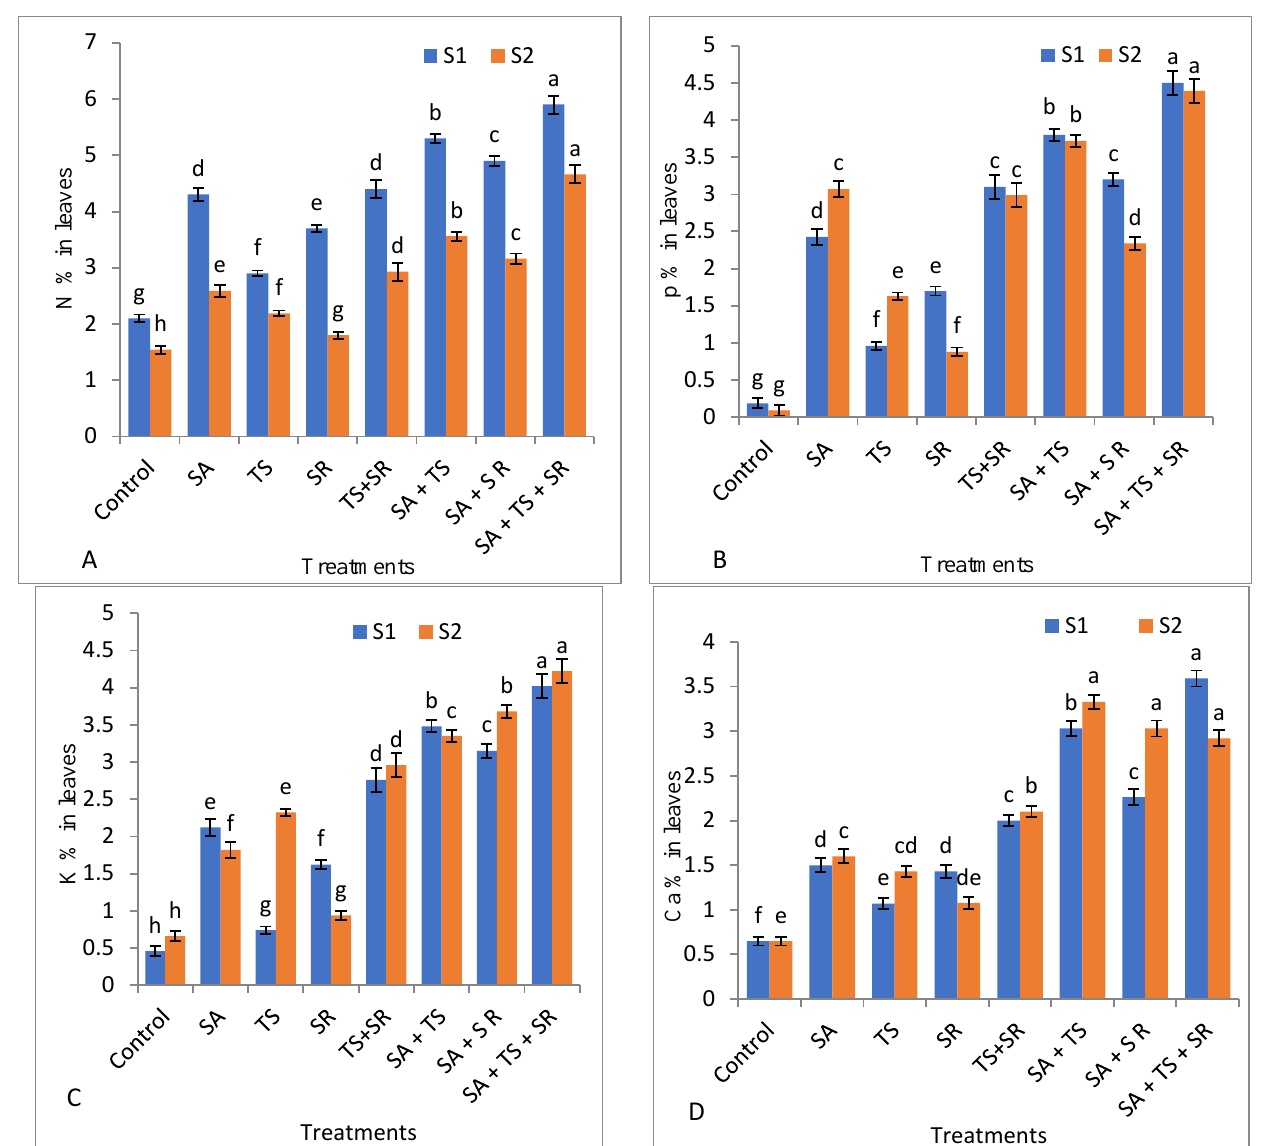
Figure 4. Effect of shikimic acid (SA) seed priming rates 40 ppm and foliar applications of water (control), T. asperellum (TS), S. rochei (SR), T. asperellum + S. rochei + (TS + SR), shikimic acid + T. asperellum (SA + TS), shikimic acid + S. rochei (SA + SR), and shikimic acid + T. asperellum + S. rochei (SA + TS + SR) on ( A ) N%, ( B ) P%, ( C ) K%, and ( D ) Ca% in leaves during two seasons. Standard errors of the mean are shown as vertical bars; the LSD test indicates that differences between values in each bar that are marked by different letters are significant at p ≤ 0.05.